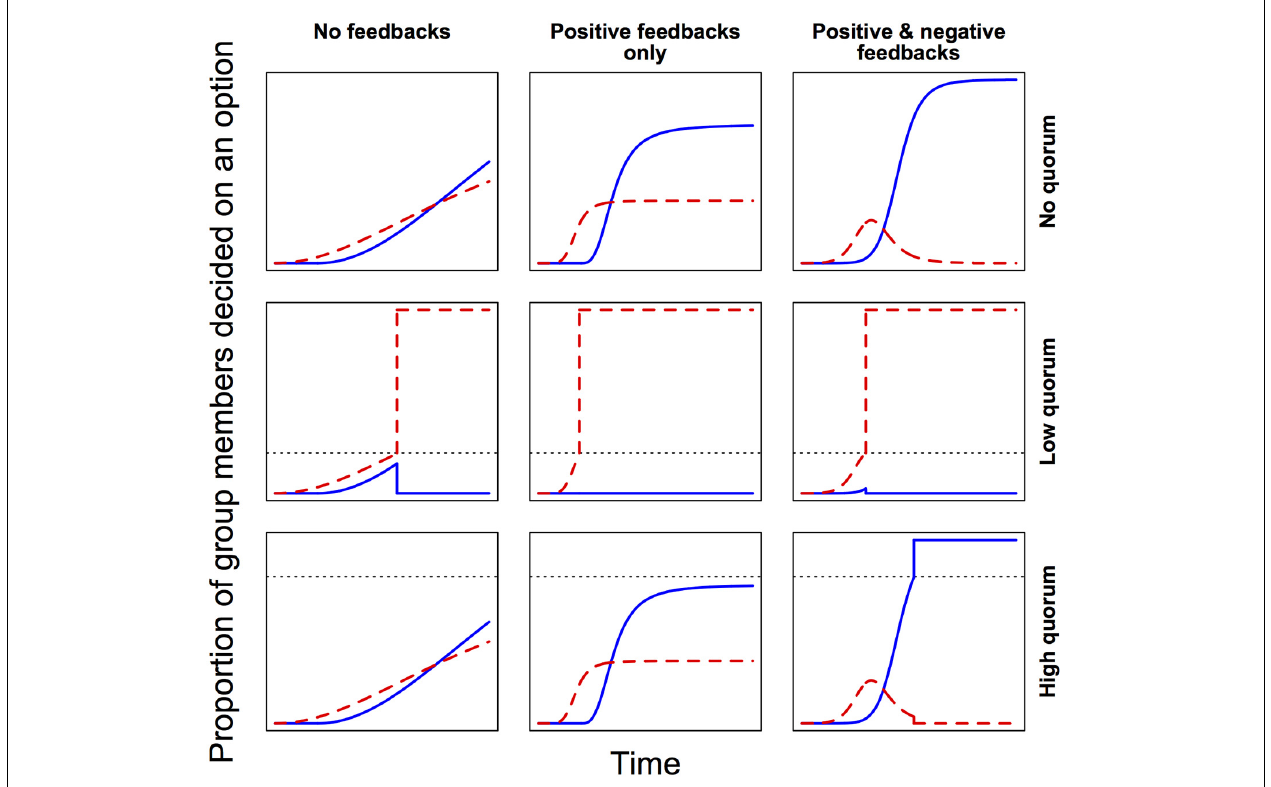
FIGURE 3 | Feedbacks and quorum thresholds modulate the speed and accuracy of collective decision-making. Here, groups are deciding between two options. Red (dashed line) is the first option to attract support, but blue (solid line) is the more accurate choice (i.e., leads to higher average fitness). Lower quorum thresholds (dotted lines) make decision-making faster, but increase the risk of suboptimal outcomes.